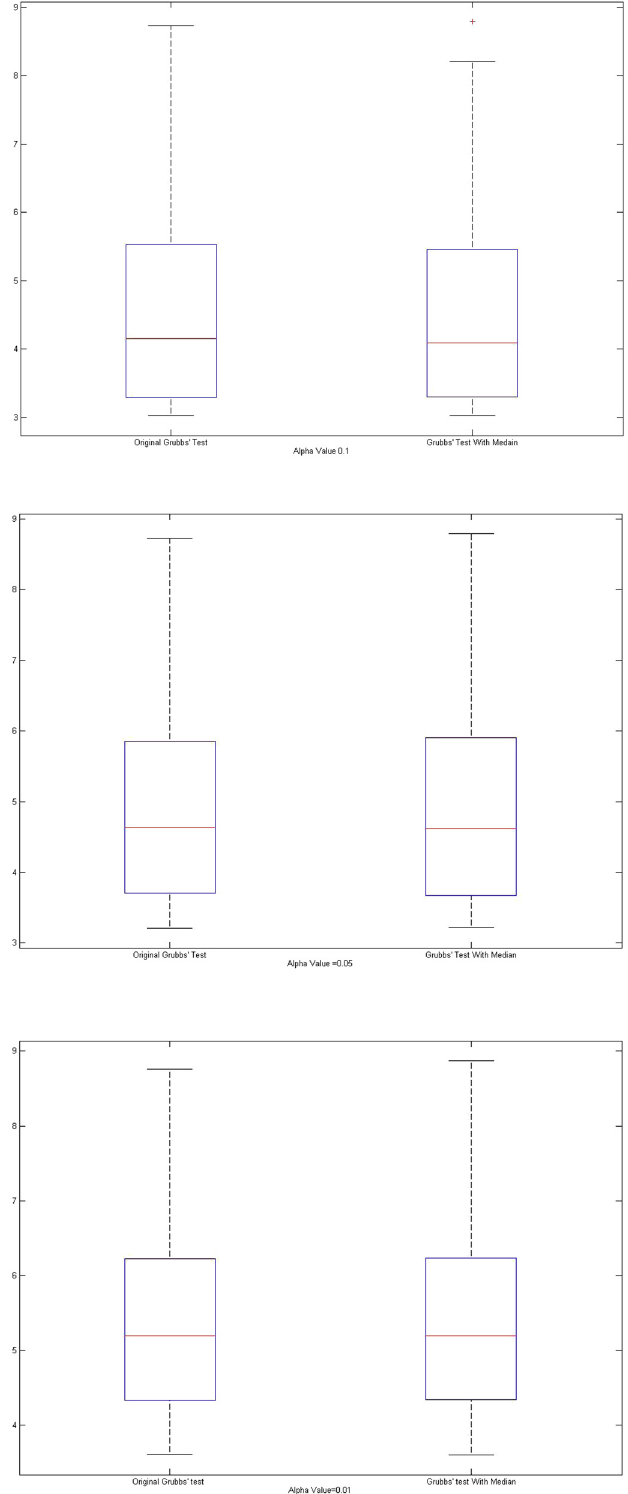
Figure 3: The box - plot for original and new Grubbs ’ test for three α values 0.1, 0.05, 0.01, respectively for 1,000 Monte Carlo